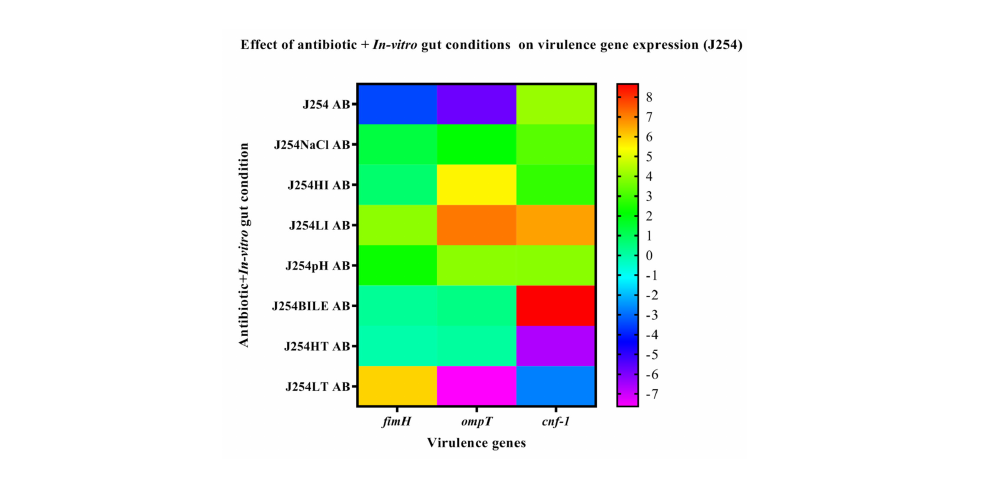
Figure 6. The expression level of virulence genes on exposure to antibiotic + in vitro gut conditions in J254 are presented using fold change values transformed to log2 format. The color scale, indi ‐ cating log2 (fold ‐ change values), is shown towards the right of the heat map.